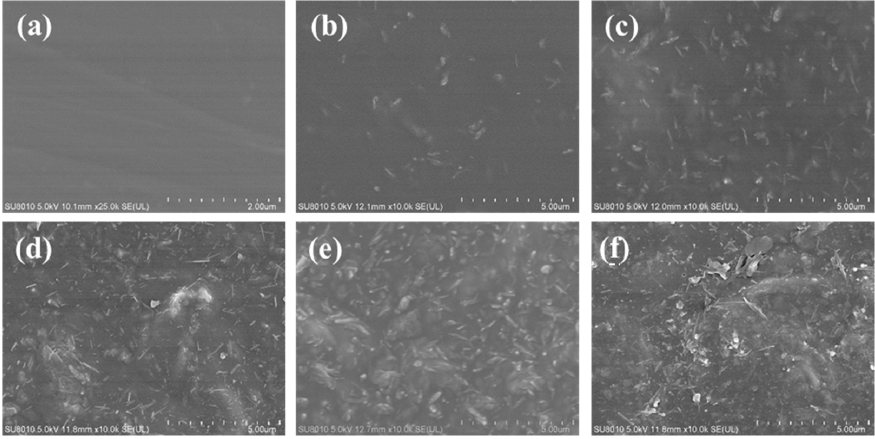
Figure 4. SEM images of the surface of membranes: ( a ) PI, ( b ) PI-10%ATP, ( c ) PI-30%ATP, ( d ) PI- 40%ATP, ( e ) PI-50%ATP, and ( f ) PI-60%ATP. ( d ) PI-40% ATP, ( e ) PI-50% ATP, and ( f ) PI-60%